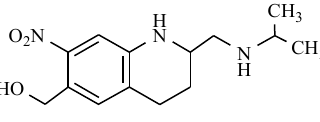
Figure 15. The chemical structure of oxamniquine.